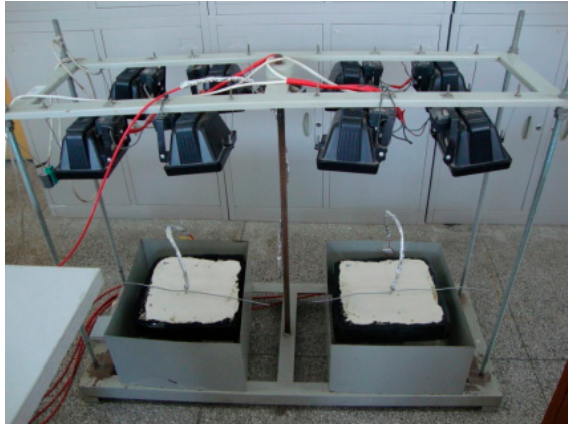
Figure 5. Simulation of solar radiation using an iodine tungsten lamp.